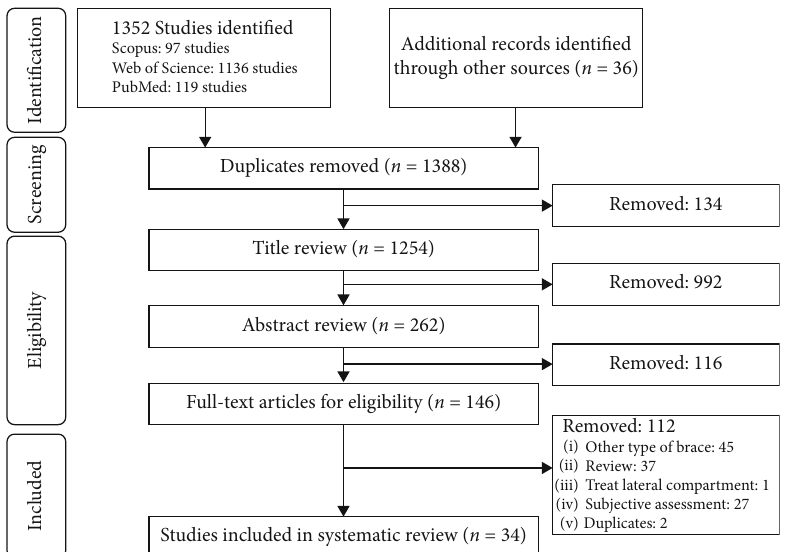
Figure 1: The PRISMA fl ow diagram of the study selection